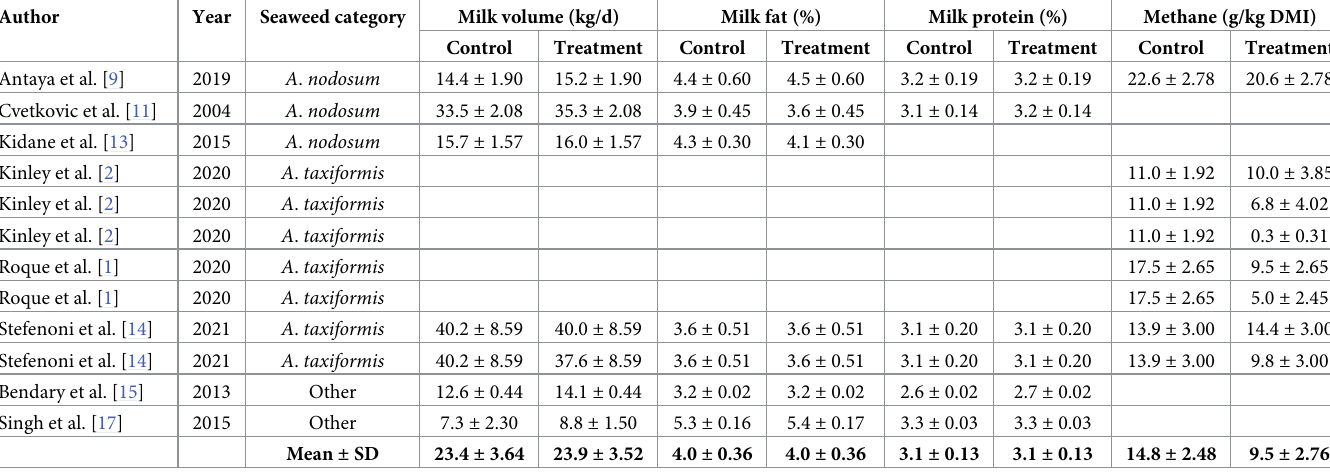
Table 3. Mean ± SD of control and treatment group milk production and methane outcomes for each comparison included in